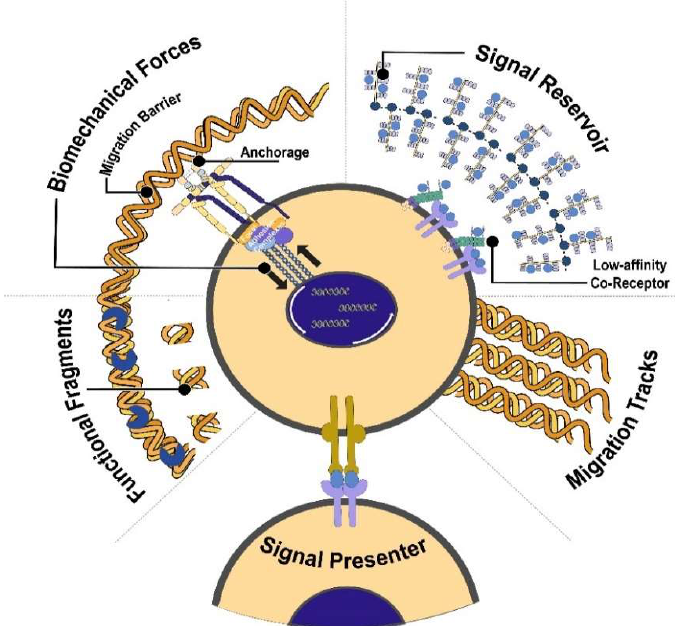
Figure 2. Functions of the ECM. The ECM serves as a point of anchorage for the cells that is essential for maintaining tissue polarity and asymmetric stem cell division. Depending on the context, it can impede or facilitate migration. It can sequester growth factors and prevent its free diffusion. Other ECM components can bind growth factors and can serve as co-receptors or signal presenters, which help determine the direction of cell-cell communication. Through the action of metalloproteinases (MMPs), fragments of the ECM can also influence cell behaviour. The physical properties of the ECM can be sensed by focal adhesion complexes, which lead to a variety of changes in cell phenotype such as reorganization of the 3D genome. Figure modified and adopted from Lu, Weaver, and Werb 2012